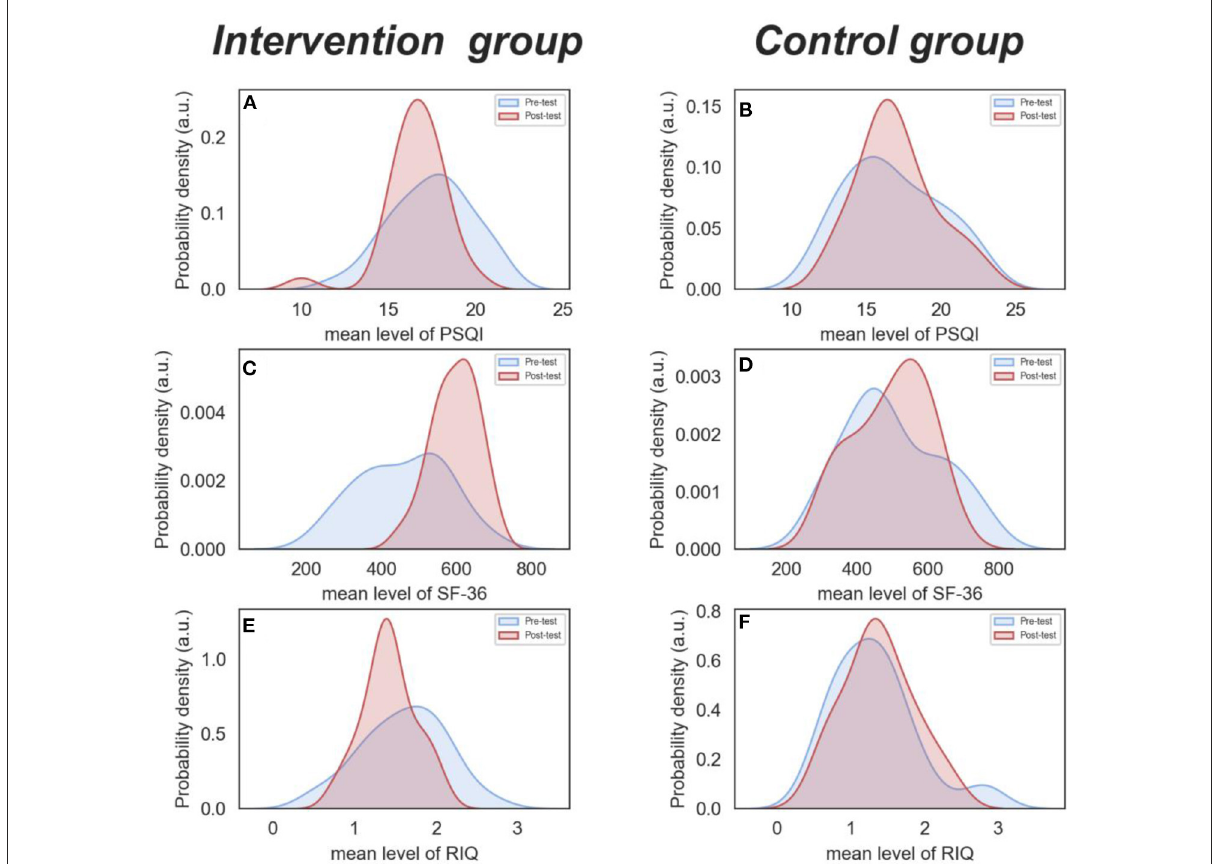
FIGURE2 (A–F) Pre-test and post-test comparison of PSQI, SF-36, and RIQ between the two groups.